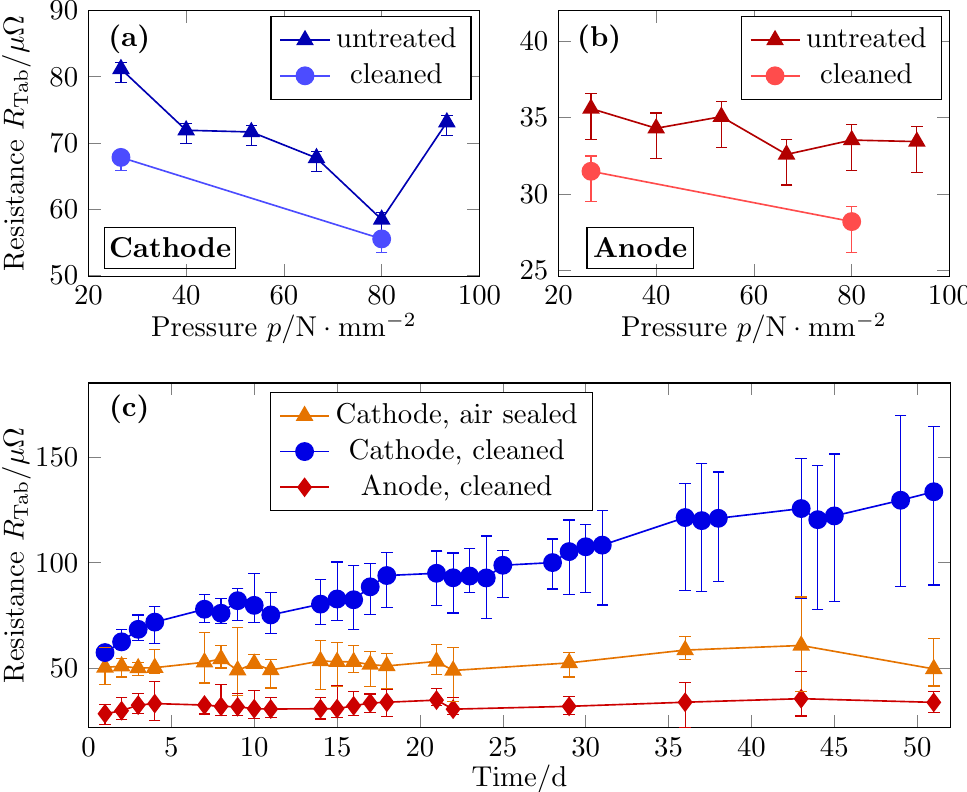
Figure 5. Impacts of tab treatment, with the influences of surface cleaning and pressure ( a , b ) as well as the effects of air sealing ( c ) on the contact resistance at the cathode (aluminum) and anode (nickel-plated copper)